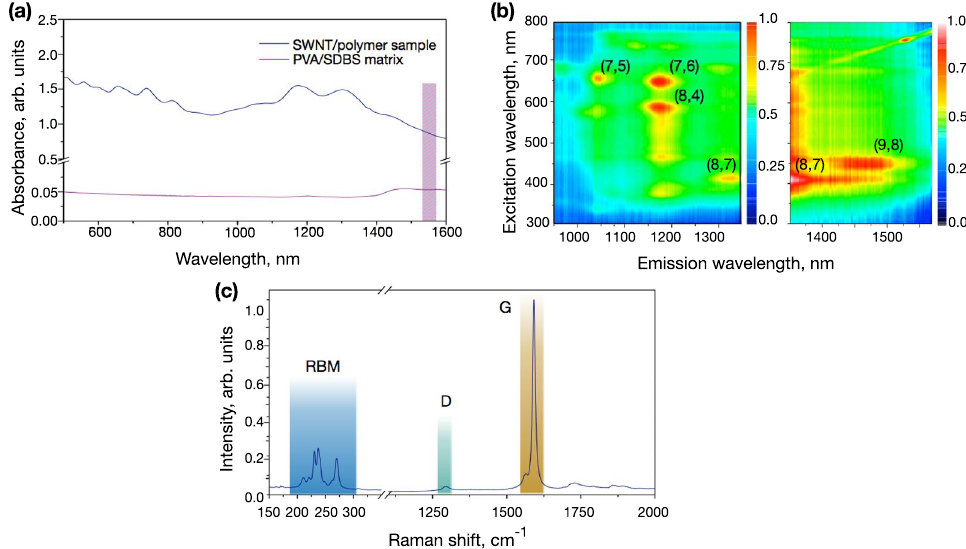
Figure 1. ( a ) UV-visible-NIR absorbance spectrum of the SWNT-PVA composite film. The contribution from the PVA matrix has been subtracted. The coloured bar at 1530–1560 nm indicates the laser operation band. ( b ) Normalised photoluminescence (PL) map of the SWNT-PVA film. ( c ) First order Raman spectrum of the SWNT-PVA composite film.